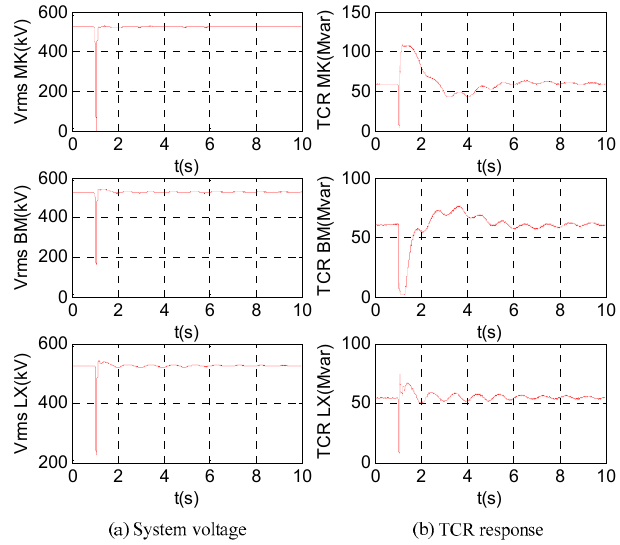
Figure 16. Dynamic response of the system under N-2 fault of the line BT-MK after SVC parameter optimization with RTDS.